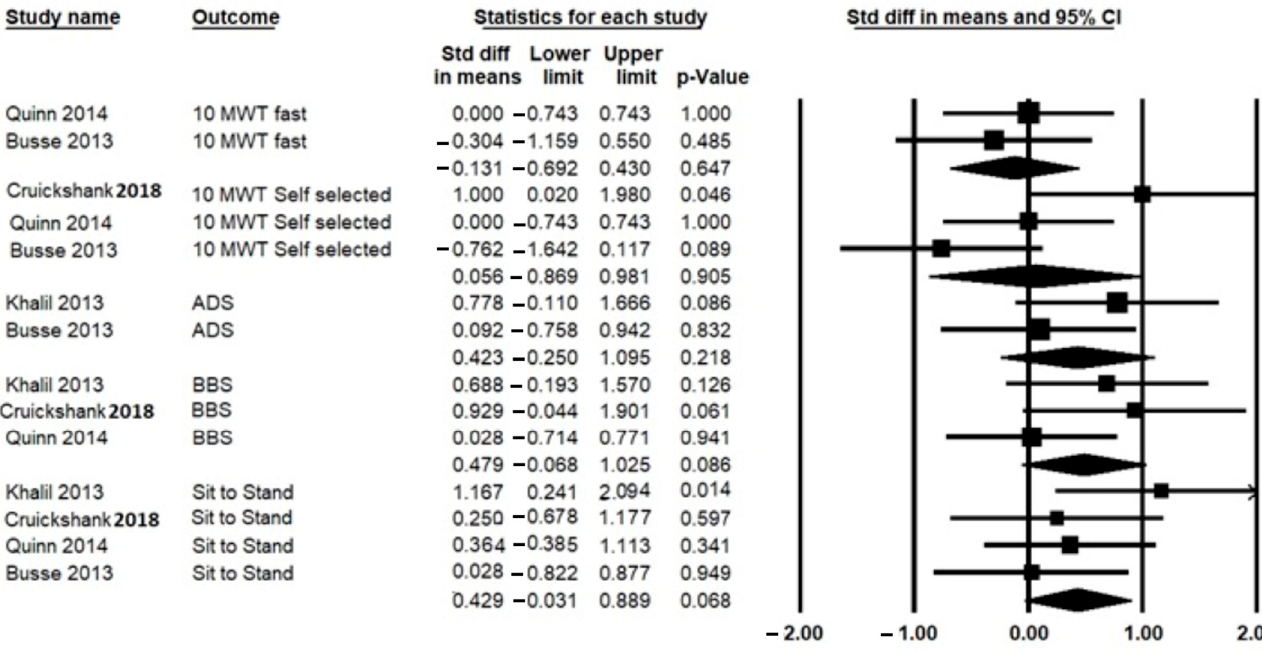
Figure 3. Forest plot for the effects of Home-based exercise (HBE) intervention compared with conventional interventions on gait speed. 10-MWT: 10-m walk test [10,18,20]; ADS: average daily steps [9,10]; BBS: Berg Balance scale [9,18,20] and sit-to-stand test [9,10,18,20]; CI: confidence interval.